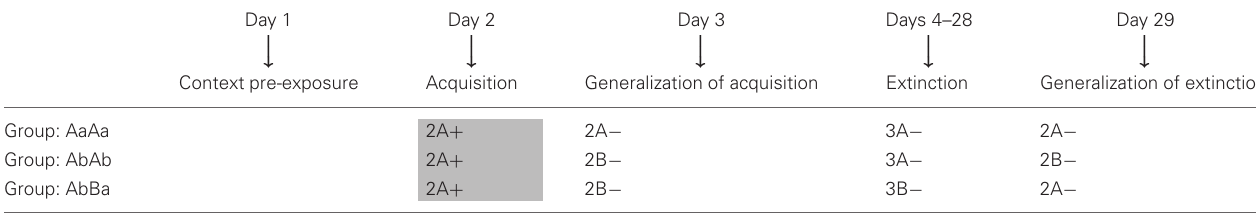
Table 1 | Timeline of the training